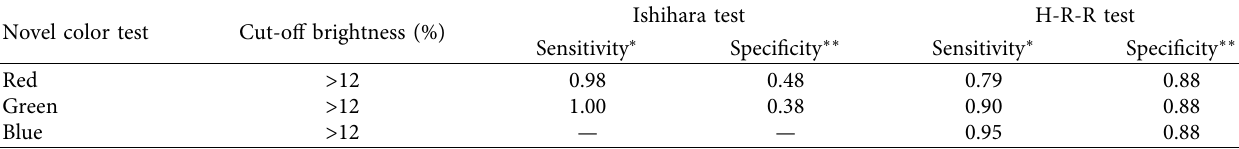
Table 6: Sensitivity and specificity of the K -color test based on Ishihara and H-R-R